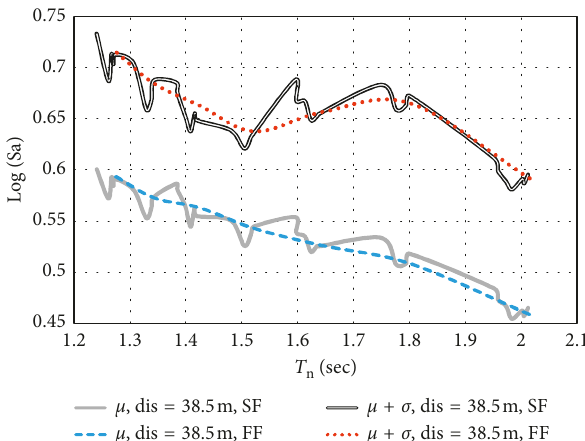
Figure 10: Mean and μ + σ for log of the spectral acceleration for models in the presence (SF) and absence (FF) of a tunnel at a distance of 38.5m from the center of the tunnel projection onto the ground